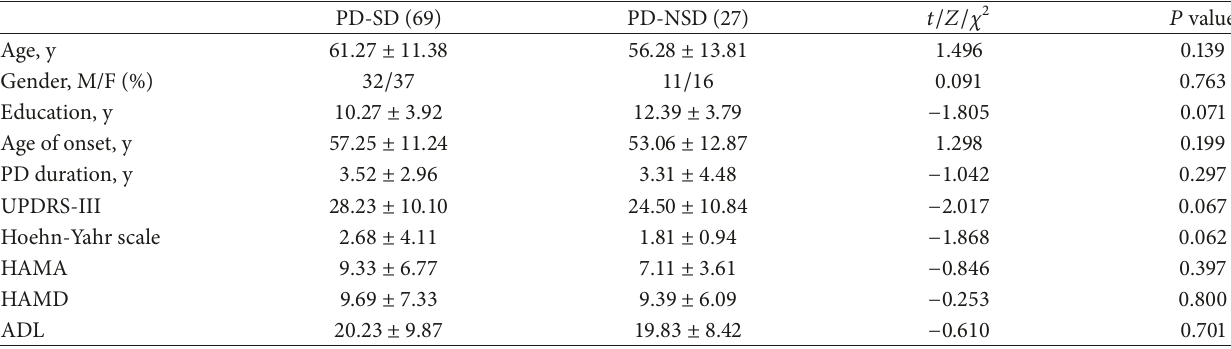
Table 2: Comparison between PD-NSD and PD with sleep disorders.